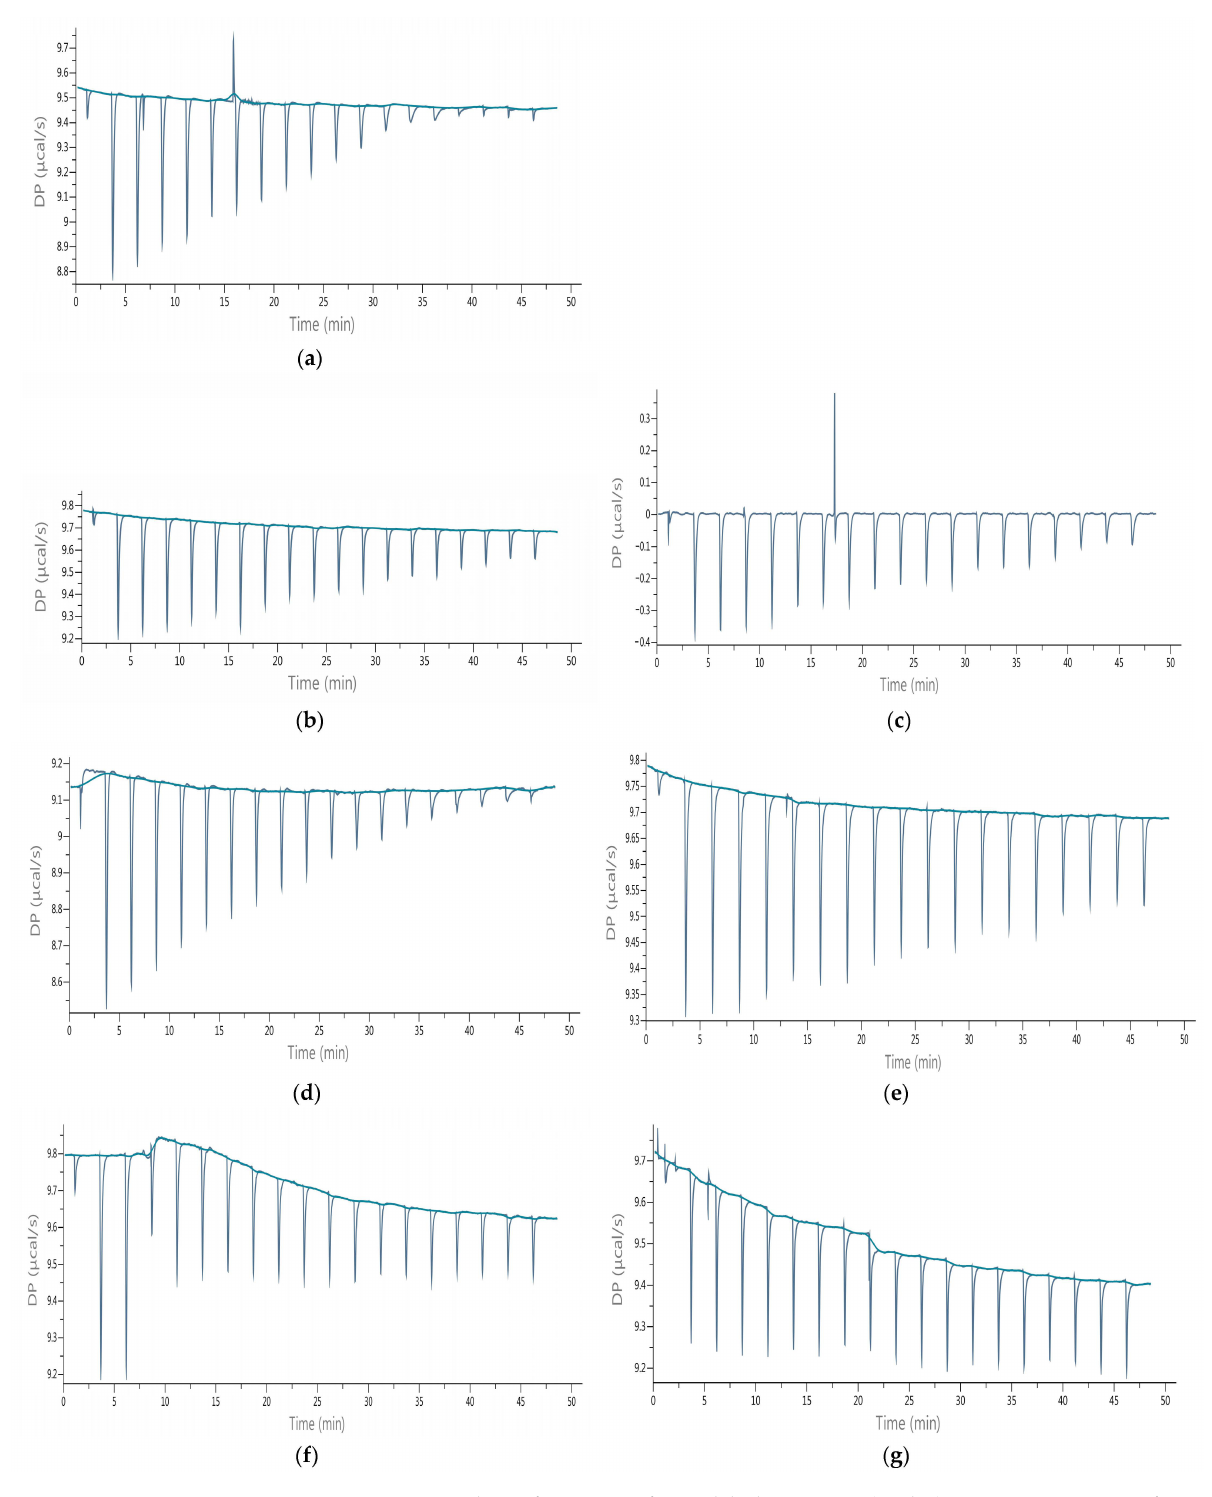
Figure 2. ITC raw data of titration of acetylcholinesterase (AChE) at a concentration of 1 µ mol/L 1 with ligands (acetylcholine (Ach), sesquiterpene lactones (SLs) or purified chicory extracts by countercurrent partition chromatography (CPC) at concentrations of 1 mmol/L (converted to lactucin content for extracts); ( a ) hydrolysis of ACh by AChE; reduced hydrolysis of ACh by AChE with: ( b ) lactucin; ( c ) lactucopicrin; ( d ) CPC 70/30 I extract; ( e ) CPC 70/30 II extract; ( f ) CPC 50/50 I extract; ( g ) CPC 50/50 II